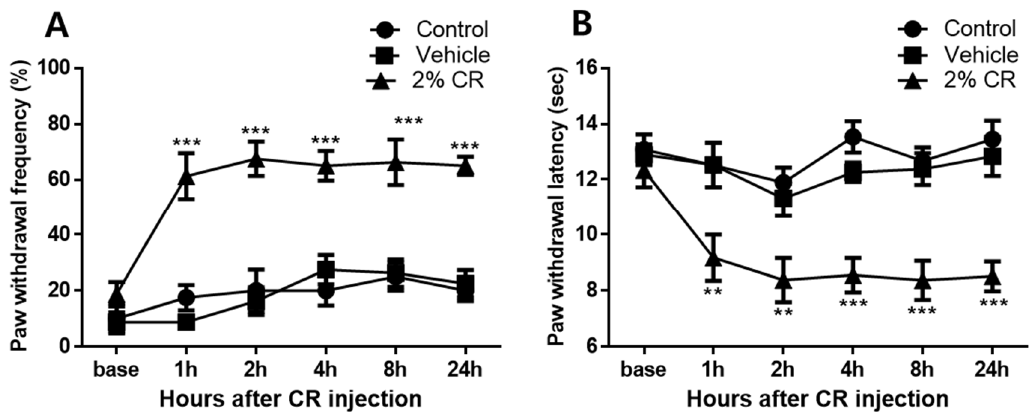
Figure 1. Graphs show the development of mechanical allodynia and thermal hyperalgesia in ipsilateral hind paws with 2% carrageenan (intraplantar) treatment. ( A ) No significant changes in paw withdrawal frequency (%) were observed in saline-treated animals (Vehicle, n = 8) over the 24 h experimental period compared to that in control animals (Control, n = 8). In contrast, the carrageenan injection group (2% CR, n = 8) exhibited a significant increase in paw withdrawal frequency in the hind limbs from 1 to 24 h after carrageenan injection, which underscores the robust development of mechanical allodynia induced by carrageenan (*** p < 0.001 compared to control mice). ( B ) No significant changes in paw withdrawal latency (sec) were observed in saline-treated animals over the 24 h experimental period compared to that in control animals. Carrageenan injection significantly decreased paw withdrawal latency from 1 to 24 h in the ipsilateral hind paw (** p < 0.01, *** p < 0.001 compared to control mice).